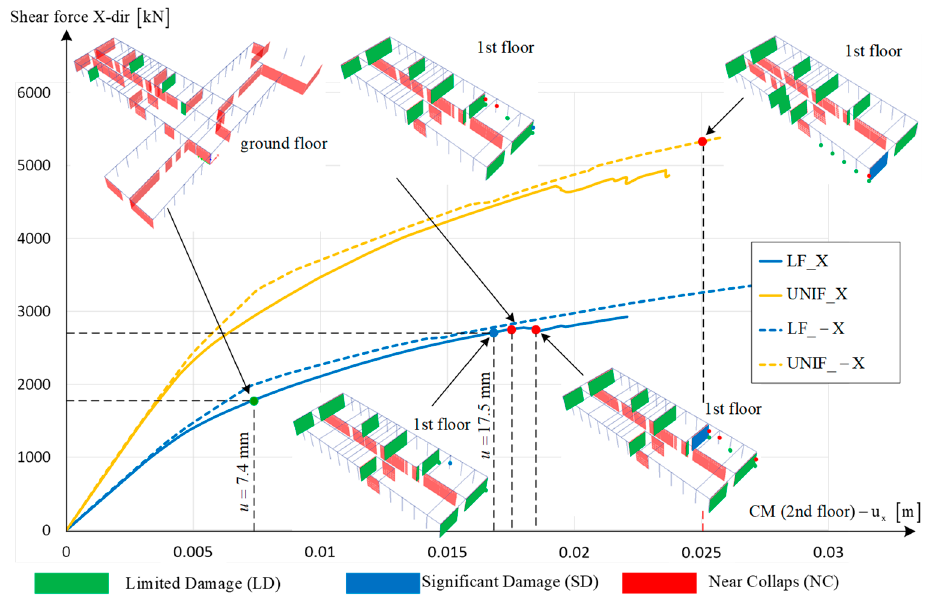
Figure 15. Pushover curves in X-dir for as-built structure.